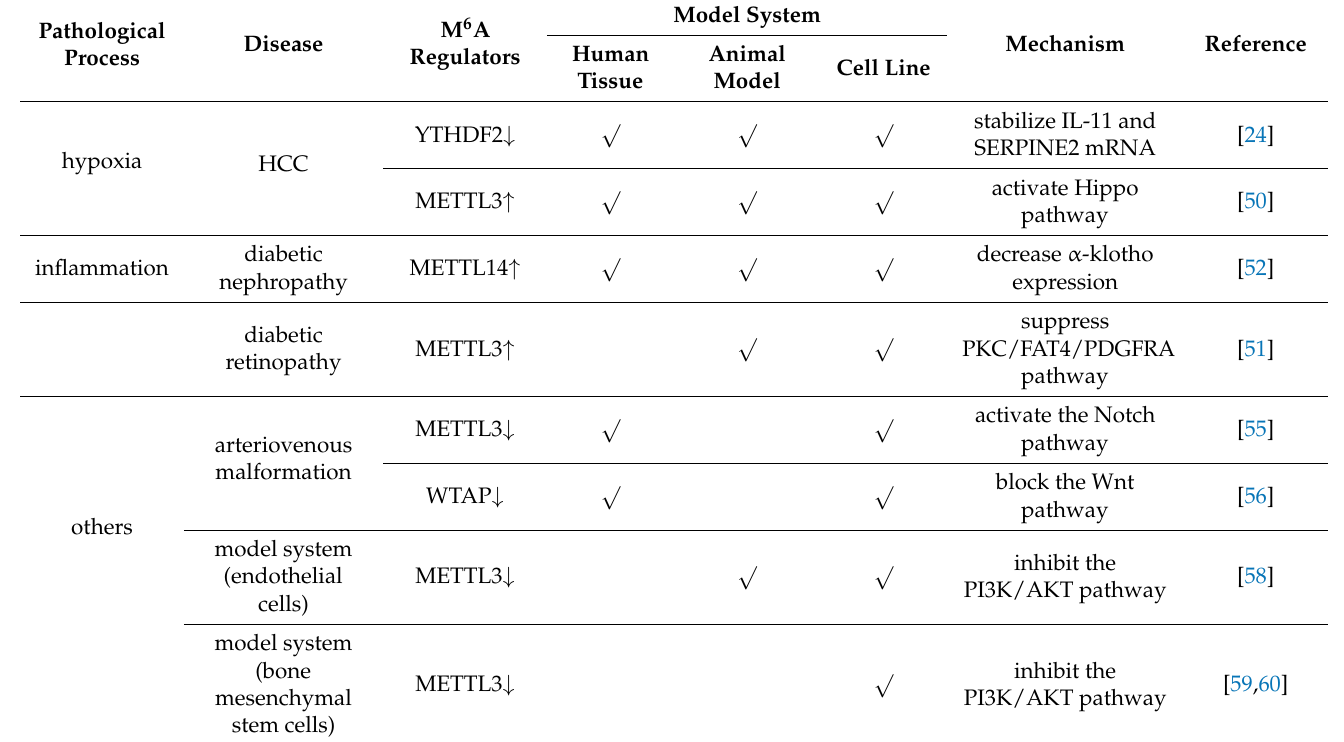
Table 2. Molecular mechanisms of m 6 A modification in microvascular